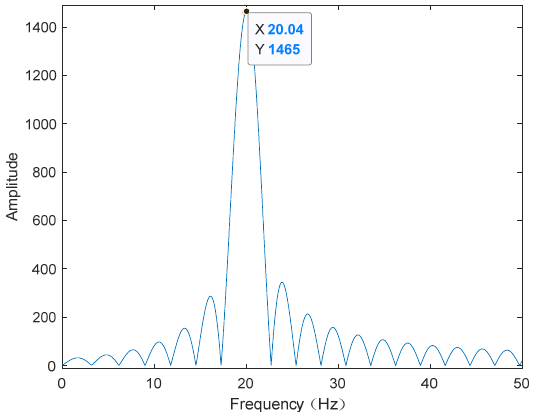
Figure 4. Frequency spectrum of high-frequency vibration acceleration.